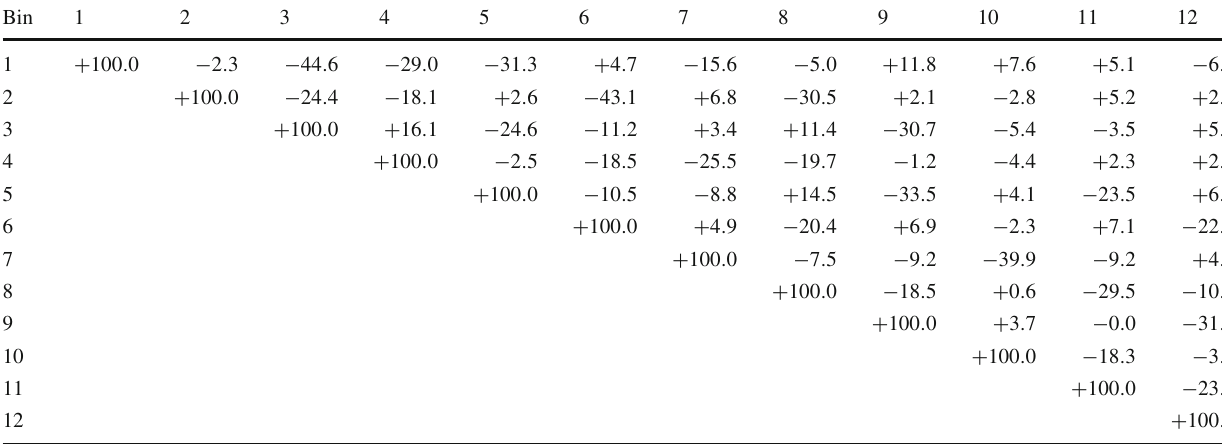
Table 21 The correlation matrix of statistical uncertainties for the normalized tt double-differential cross sections as a function of M ( tt ) and Δφ( t , t ) . The values are expressed as percentages. For bin indices see Table 20 Bin